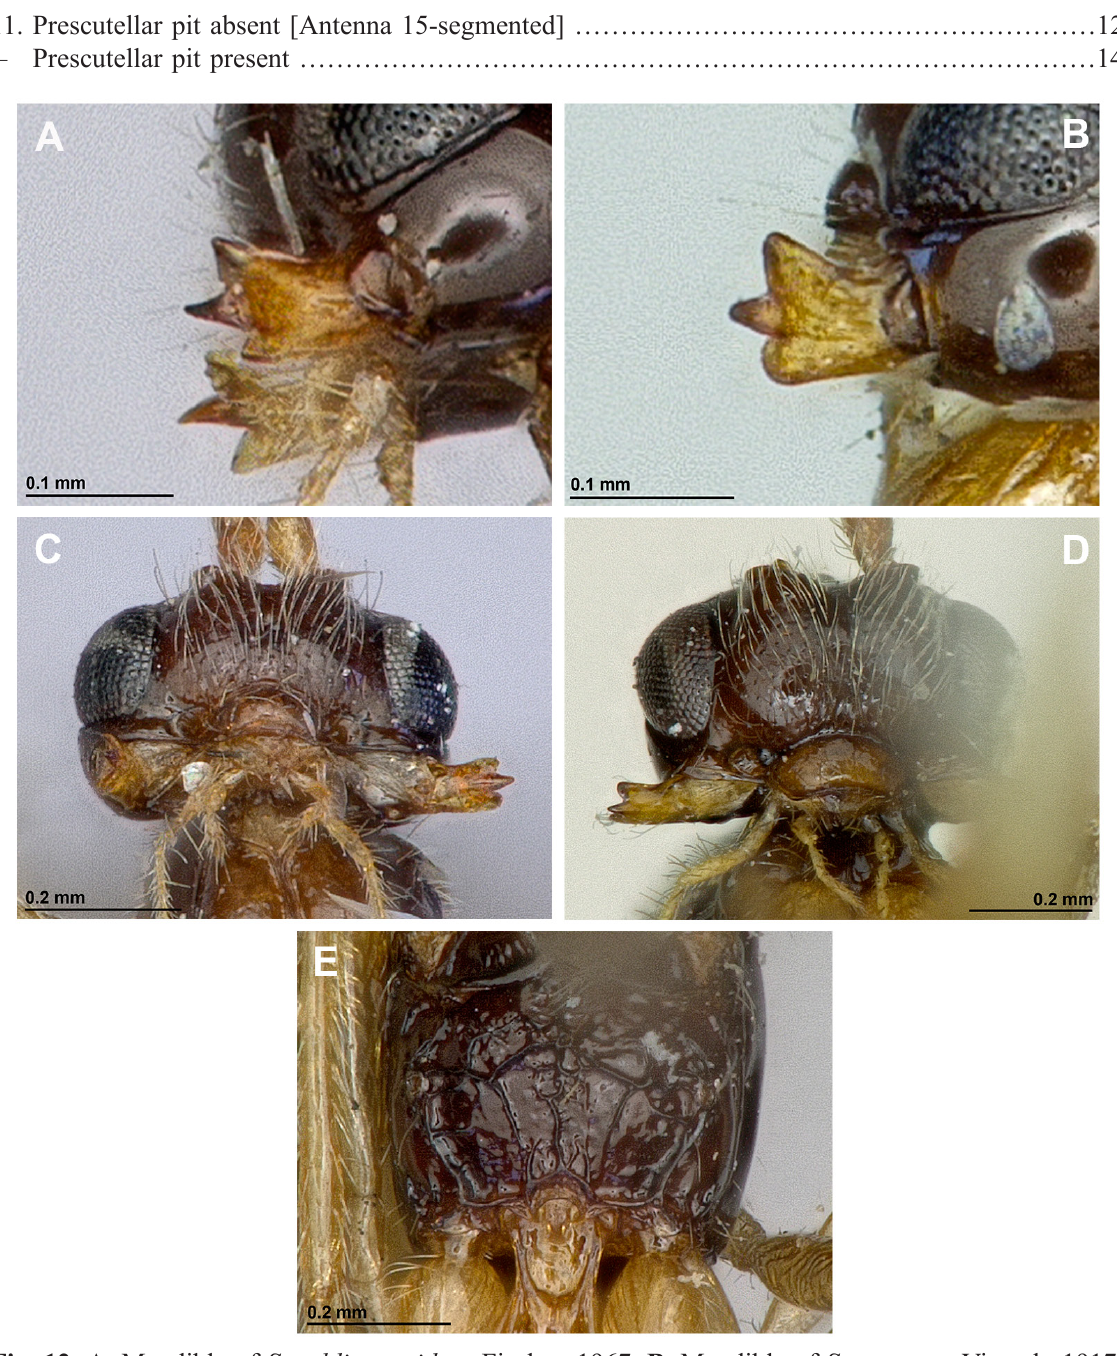
Fig. 12. A . Mandible of Synaldis acutidens Fischer, 1967. B . Mandible of S. pygmaea Viereck, 1917. C . Face of S. rotundidens Fischer, 1967, front view. D . Face of S. segmentata Fischer, 1967, front view. E . Propodeum of S. glabrifovea Fischer, 1967,